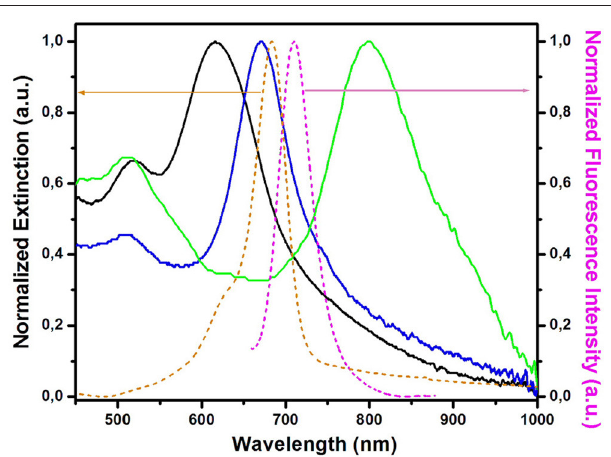
FIGURE 1 | Spectral overlap between the normalized extinction spectra of the plasmonic nanoplatforms (solid spectra) after the AuBPs immobilization (paper@AuBPs 618–black spectrum, paper@AuBPs 675–blue spectrum, and paper@AuBPs 800–green spectrum) together with the absorption (orange dashed spectrum), and fluorescence emission (magenta dashed spectrum) of the free streptavidin@Alexa 680 conjugate adsorbed on the bare Whatman